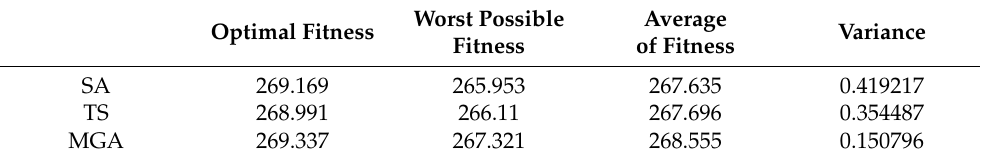
Table 4. Experimental results of crossover operator performance